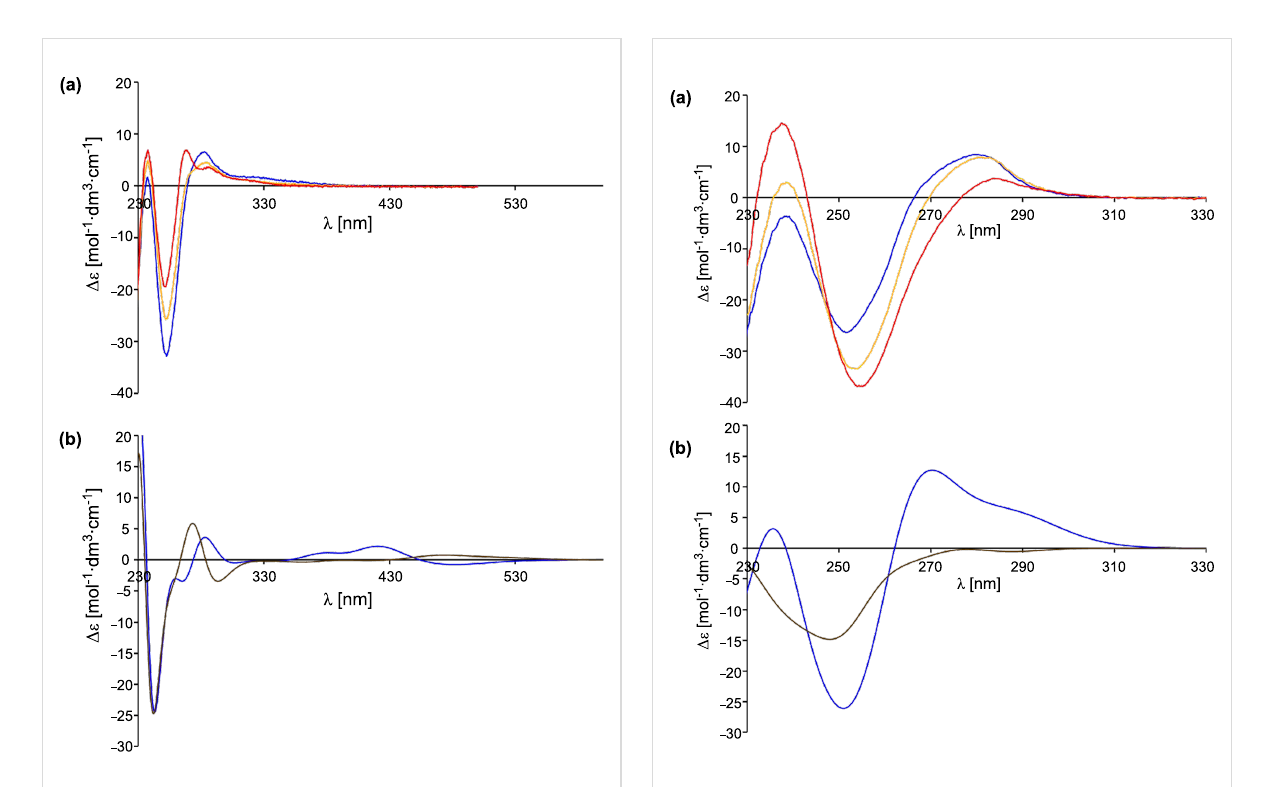
optimized ground-state geometries of ( M )- 13 and ( P )- 13 , calcu-